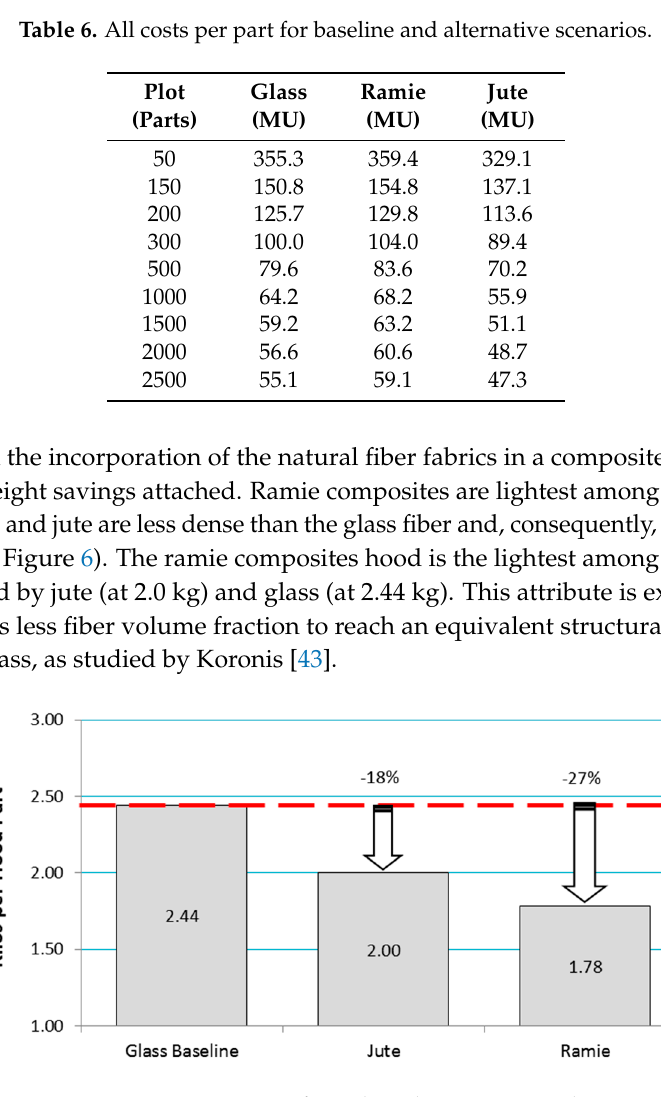
Figure 6. Summary of weight reduction potential.